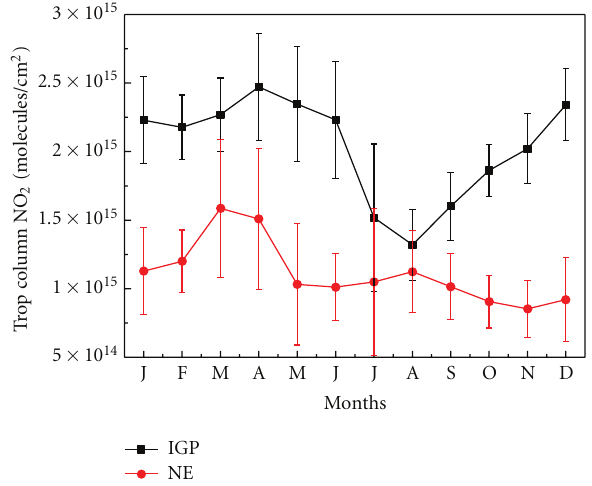
Figure 3: Month-to-month variation of tropospheric NO 2 mea- sured by SCIAMACHY and GOME over IGP and NE from 1996–